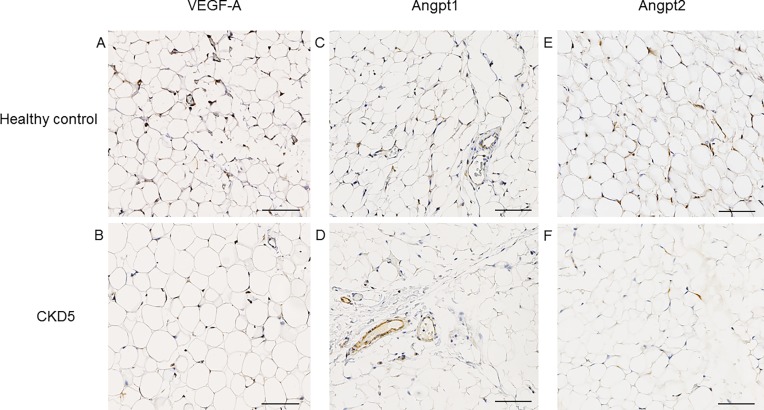
VEGF, Angpt1 and Angpt2 in omental tissue.Quantitative immunohistochemistry for VEGF (A), Angpt1 (B) and Angpt2 (C) in CKD 5 patients and controls. The Angpt2 expression was significantly lower in CKD children (p = 0.0137), Mann-Whitney test.